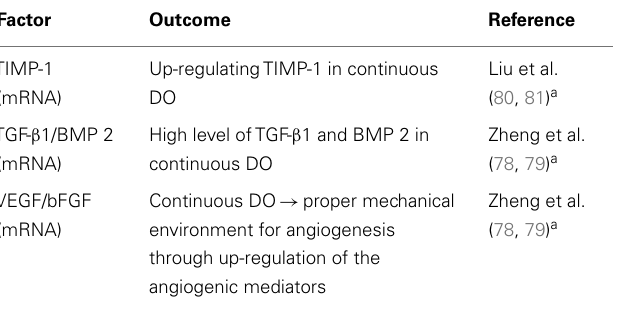
Table 3 | Factor expression in continuous versus intermittent distraction osteogenesis in rabbit mandibles .